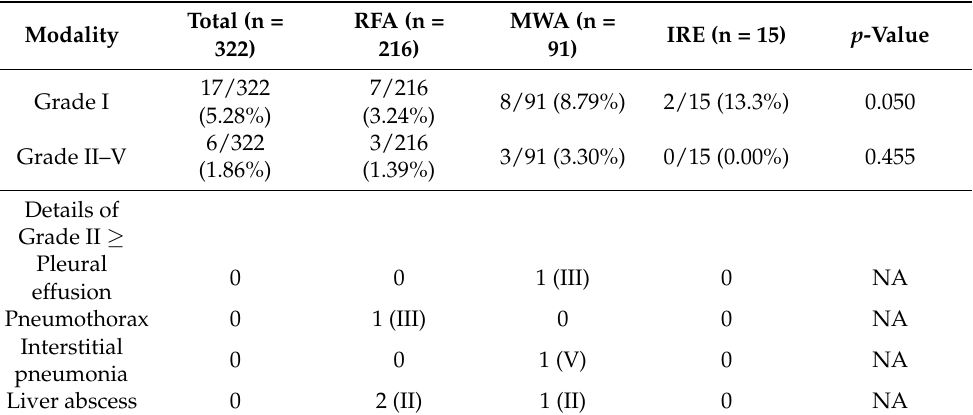
Table 7. Complications based on the Clavien–Dindo